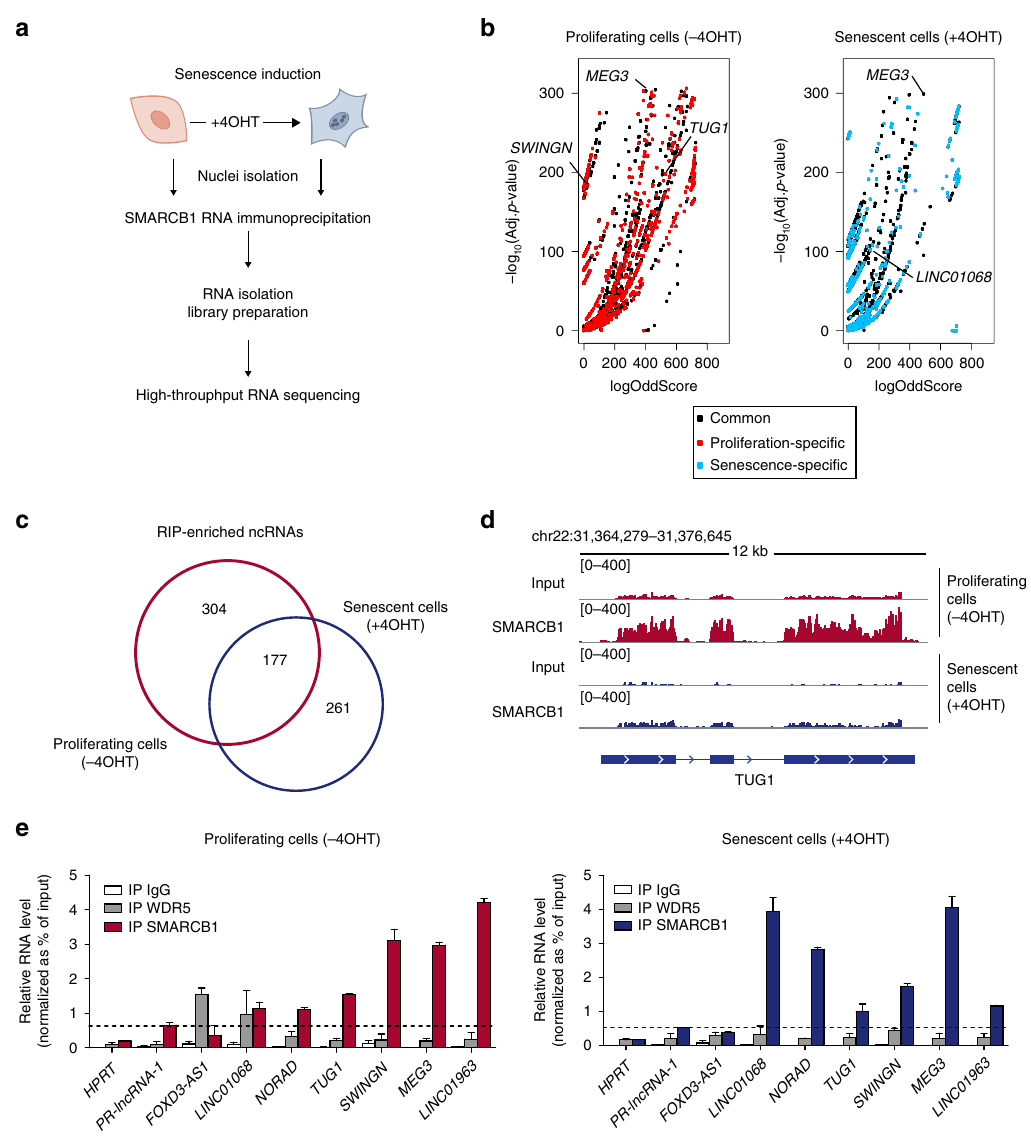
Fig. 1 SMARCB1 RIP-seq reveals differential interactions with RNA upon senescence induction. a Schematic work fl ow of SMARCB1 RIP followed by high-throughput sequencing performed on proliferating BJ ER:RAS cells or induced to senescence after 6 days of OIS; n = 3 biological replicates. b Volcano plot representing enriched SMARCB1-interacting RNA molecules in proliferating ( − 4OHT; left panel) or senescent ( + 4OHT; right panel) conditions, as calculated by ripseeker package (Materials and methods). On x -axes, logOddScore values correspond to fold induction value of IP/Input while adjusted p -value (Adj. p -value) based on posterior probability is plotted on y -axes. Transcripts enriched in both conditions are represented as black dots while proliferation or senescence-speci fi c RNAs are labeled in red or blue, respectively. c Venn diagram showing the overlap between ncRNAs (which include lincRNA, antisense, miscRNA, scaRNA, and miRNA) enriched in SMARCB1 IP in proliferating ( n = 481, red-colored) and senescent conditions ( n = 438, blue-colored). Signi fi cantly enriched ncRNAs were selected based on the following fi lters: Adj. p -value ≤ 1e − 10 , logOddScore> 1. d RIP-seq signal of Input and SMARCB1 IP at TUG1 genomic locus in proliferating (red color, − 4OHT) and senescent (blue color, + 4OHT) BJ cells. e Validation of a set of lncRNAs by SMARCB1 RIP followed by RT-qPCR. RNA enrichment in SMARCB1 IP was calculated as percentage of input, using WDR5 and IgG IPs as control. SWINGN was ampli fi ed with primer set#2. HPRT and p53-regulated lncRNA-1 ( PR-lncRNA-1 ) are negative controls. n = 3 ( n = 2 for WDR5 RIP) biological replicates shown as mean ± SD. Source data of this Figure are provided as Source data fi